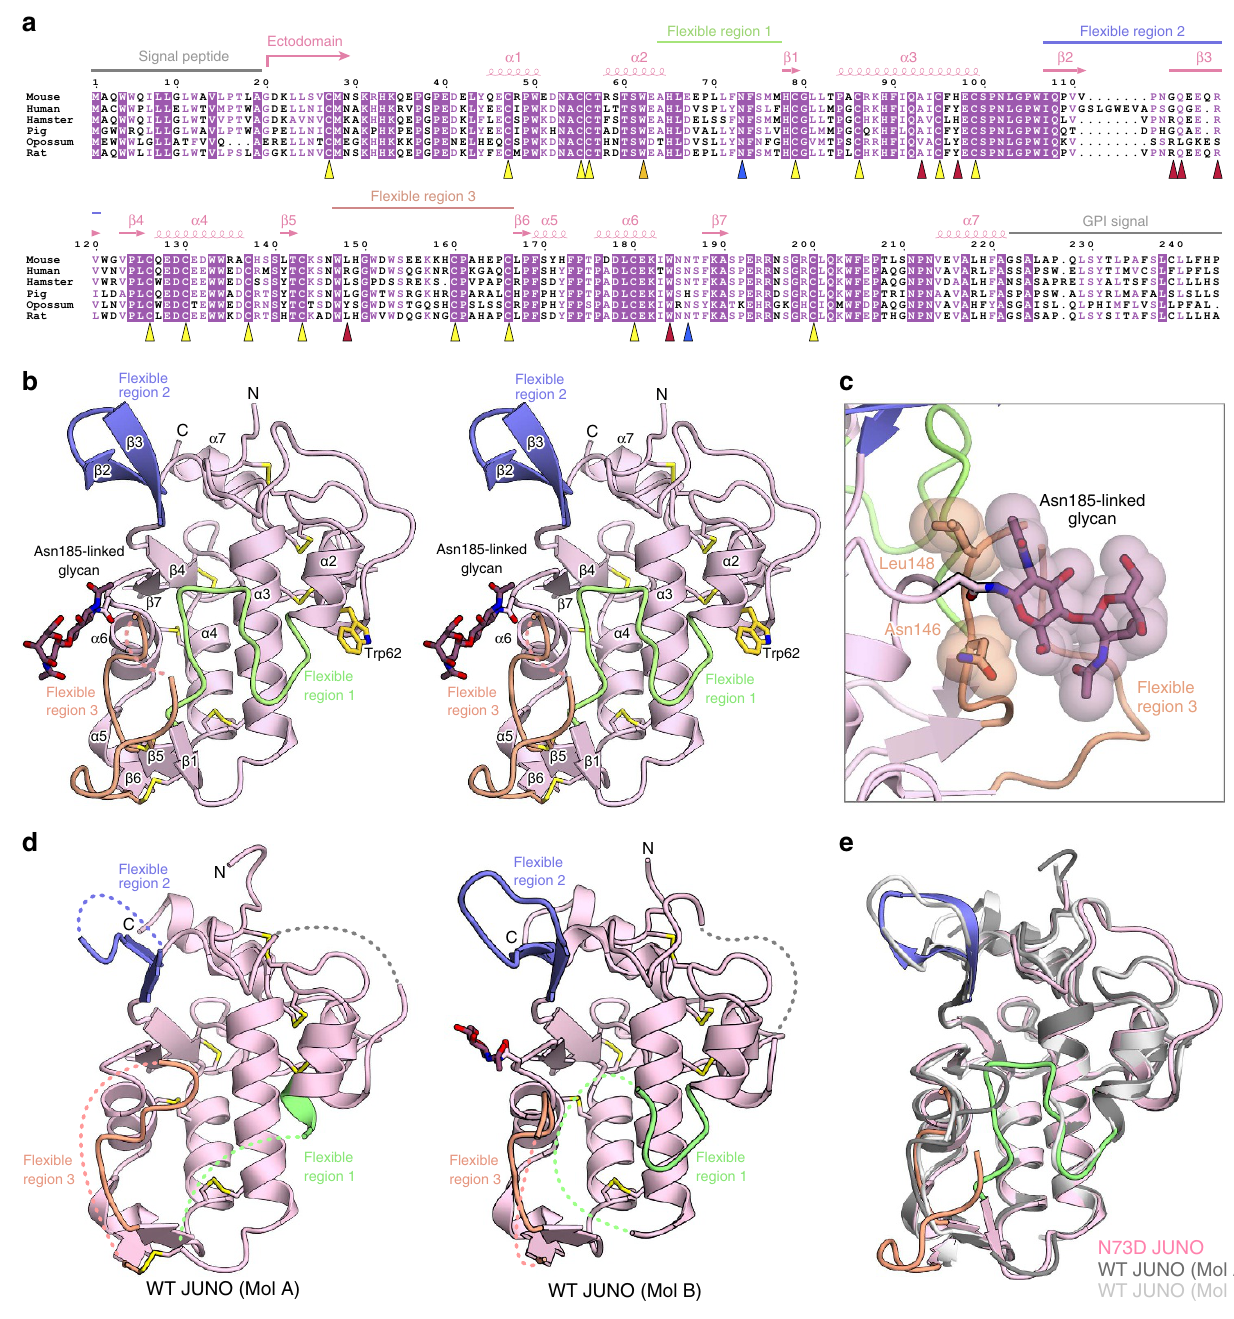
Figure 1 | Crystal structure of JUNO. ( a ) Multiple sequence alignment of JUNOs from different species. In mouse JUNO, the two glycosylation sites (Asn73 and Asn185) and the eight conserved disulfide bonds are indicated by blue and yellow triangles, respectively. Trp62 is indicated by a gold triangle. Residues forming the central pocket are indicated by red triangles. ( b ) Ribbon representation of the N73D mutant ectodomain of mouse JUNO (stereo view). Flexible regions 1–3 are coloured green, blue and orange, respectively. The disulfide bonds and N-linked glycans are shown as stick models, and the disordered regions are shown as dashed lines. Trp62 is shown as a gold stick. ( c ) Asn185-linked glycan. The Asn185-linked glycan and the side chains of Asn146 and Leu148 are depicted as stick and space-filling models. ( d ) Ribbon representations of the ectodomain of WT JUNO (PDB code 5EJN) 13 . Mol A (left) and Mol B (right) are shown as in b . ( e ) Superimposition of our N73D mutant JUNO (coloured) and WT JUNO (PDB code 5EJN) (grey) 13